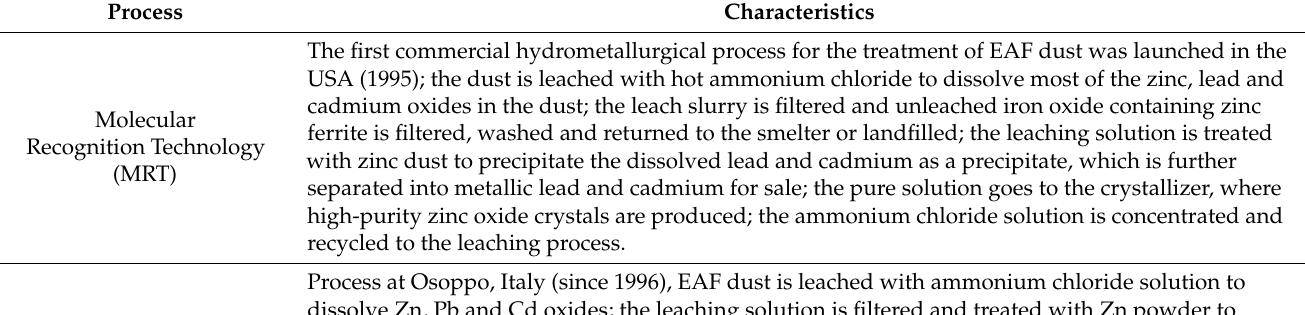
Table 8. Characteristics of metallurgical methods for processing secondary zinc waste [77,79–82].